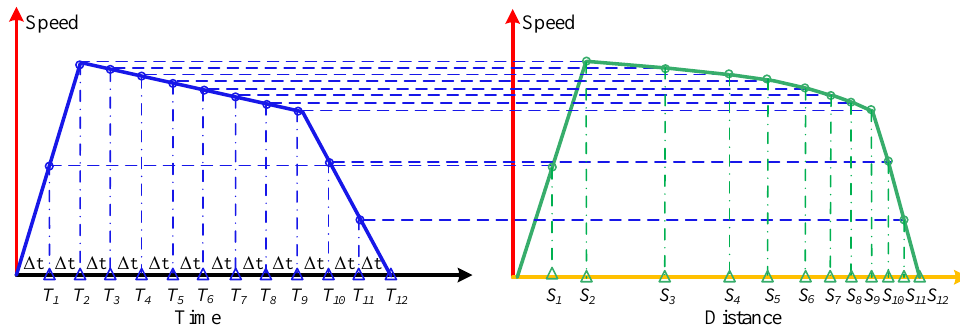
Figure 2. The discretization process of the interstation section is based on the proposed time-based MILP model. The blue and green solid lines are the train speed trajectory. The blue and green circles are the corresponding speed points in each time segment ∆ t and the blue dotted lines are discrete divisions mapped to